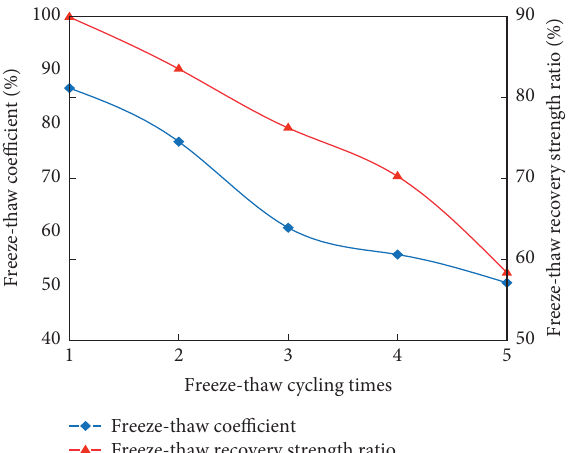
Figure 21: Freeze-thaw coefficient and recovery strength under different freeze-thaw cycle ratios under different freeze-thaw cycles.